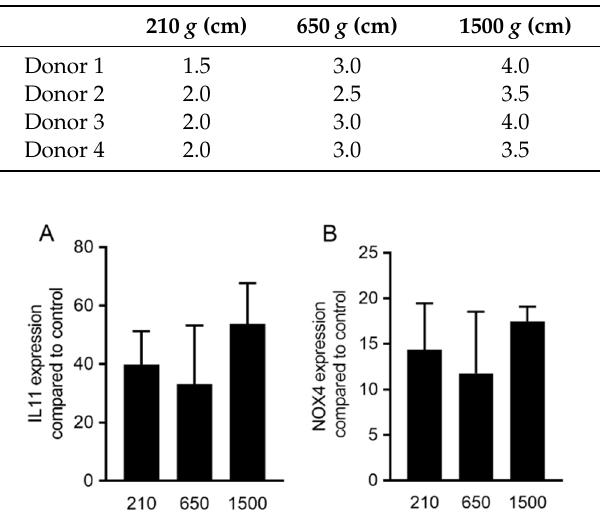
Figure 1. PRF lysates prepared at 210 g , 650 g and 1500 g provoked a robust increase of TGF- β target genes. Gingival fibroblast cells were exposed to 30% of PRF lysates prepared at di ff erent g -forces (210, 650 and 1500 g ). Analysis of gene expression changes revealed that IL11 ( A ) and NOX4 ( B )